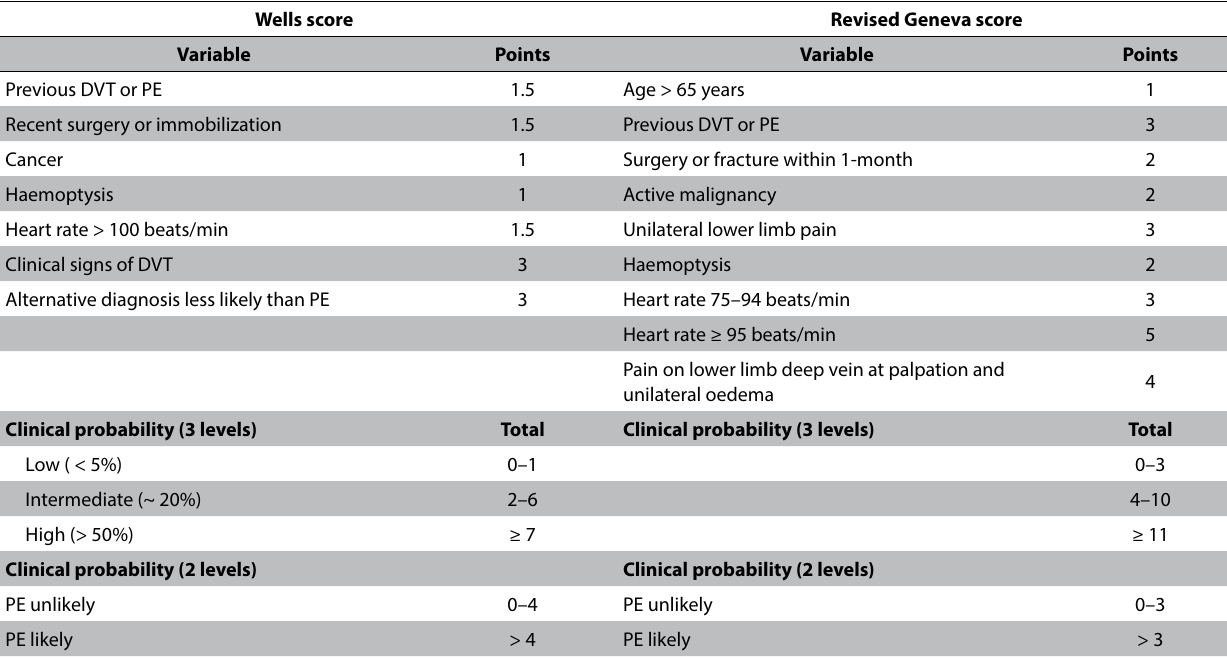
Table 2: Wells and revised Geneva scores